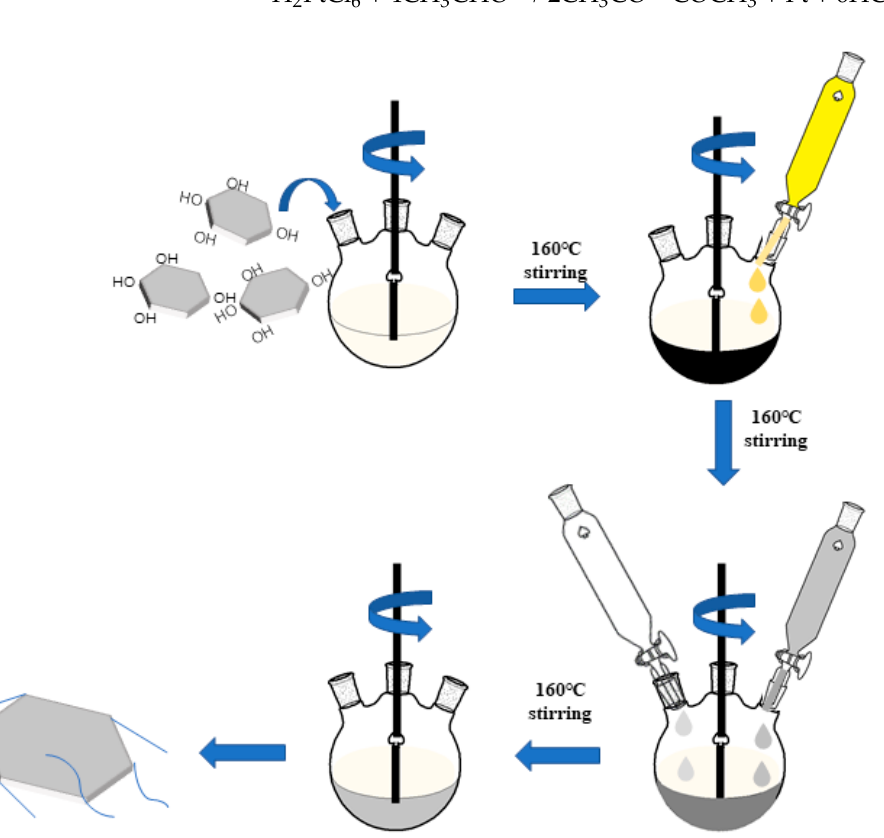
Figure 1. Schematic illustration of the preparation procedures for BN@AgNWs (boron nitride@silver nanowires). (Yellow: Chloroplatinic acid, gray: Silver nitrate solution, transparent: Polyvinylpyrrolidone (PVP) solution).